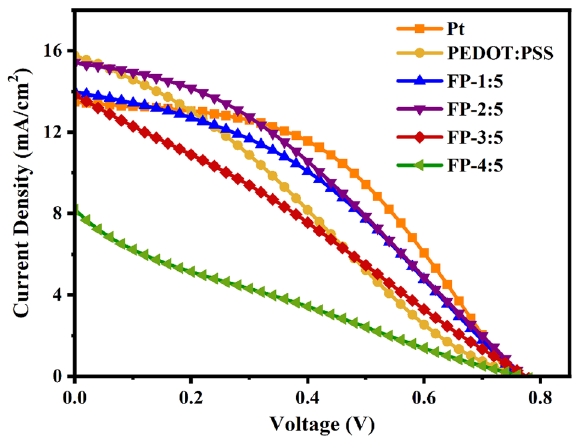
Figure 12. J-V curves of DSSCs assembled with various CEs under AM 1.5G (100 mW/cm 2 ).